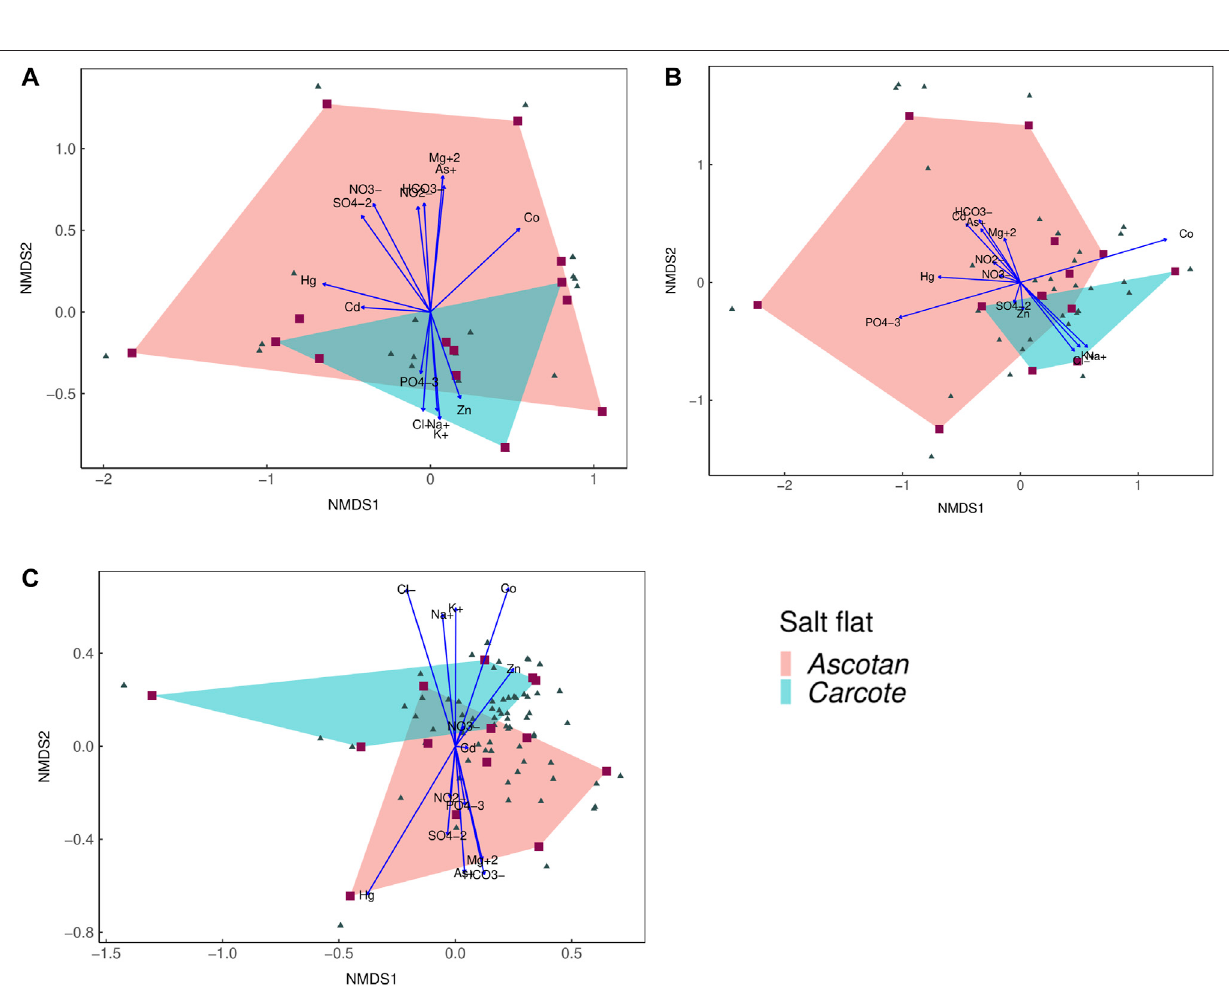
Frontiers in Environmental Science |